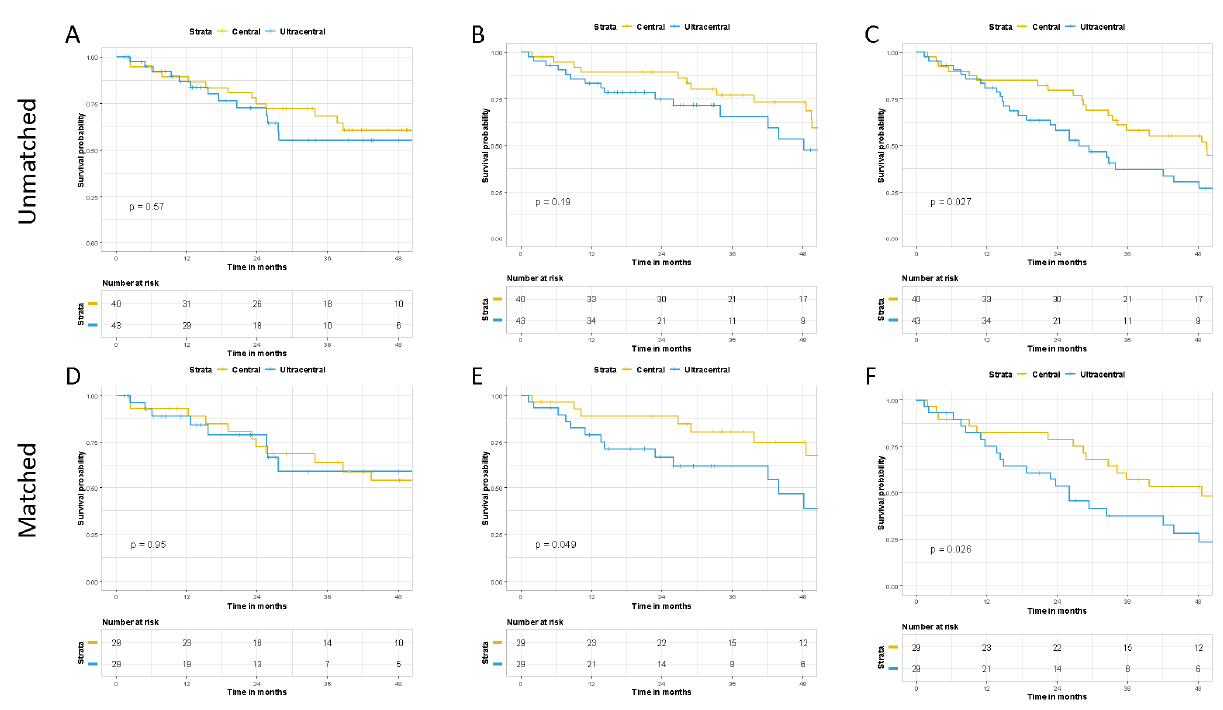
Figure 1. Comparing outcomes of central and ultracentral lung tumors. Freedom-from progression ( A , D ), non-cancer associated survival ( B , E ), and overall survival ( C , F ) for the unmatched and matched cohorts respectively.